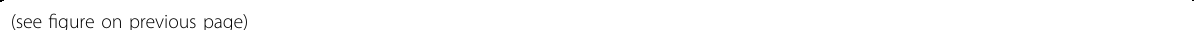
Fig. 1 mGluR2 is required for SARS-CoV-2 infection and directly interacts with the S protein. a Knockdown of mGluR2 was measured by use of qPCR in Vero-E6 cells, Caco-2 cells, and HPAE cells. simGluR2#1 and simGluR2#2, siRNAs speci fi c for mGluR2 mRNA from monkey and human, respectively. siControl, scrambled RNA. b , c mGluR2-silenced Vero-E6 cells ( b ), Caco-2 cells ( b ) or HPAE cells ( c ) were infected with HRB25. At 24 h p.i., virus in the culture supernatant or in the cell lysate (HPAE cells) was detected by use of plaque assays or qPCR. d , e mGluR2-transfected cells were infected with HRB25. At 24 h p.i., virus in the culture supernatant was detected by use of plaque assays ( d ). The expression of exogenous mGluR2 in HEK293 cells and HEK293-ACE2 cells was con fi rmed by western blotting assay ( e ). f – i mGluR2-Flag and SARS-CoV-2 S-Myc ( f ), SARS-CoV-2 S1-Myc ( g ), SARS-CoV-2 RBD-Myc ( h ), or SARS-CoV-2 S1- Δ RBD-Myc ( i ) were co-transfected into HEK293 cells and then immunoprecipitated by using anti-Flag agarose beads. j – l Puri fi ed recombinant GST-tagged mGluR2 ectodomain (mGluR2-GST) was pooled with lysate from SARS-CoV-2 S-Myc- ( j ), SARS- CoV-2 S1-Myc- ( k ) or SARS-CoV-2 RBD-Myc- ( l ) transfected HEK293 cells and then pulled down by using anti-GST beads. m , n mGluR2-GST was pooled with cell lysate from SARS-CoV-2-infected Vero-E6 cells ( m ), or puri fi ed SARS-CoV-2 S1 subdomain protein (SARS-CoV-2 S1-His) ( n ) and then pulled down by using anti-GST beads. o , p Vero-E6 cells ( o ), Caco-2 cells ( o ), and HPAE cells ( p ) were treated with mGluR2-Ab at different concentrations or IgG2a (20 μ g/mL for Vero-E6 cells and Caco-2 cells; 15 μ g/mL for HPAE cells) for 1 h at 4 °C, and then infected with HRB25. Virus in the culture supernatant or in the cell lysate (HPAE cells) was detected by use of plaque assays or qPCR at 48 h p.i.. q HRB25 was pooled with different concentrations of mGluR2-GST or GST (200 μ g/mL), and then Vero-E6 cells were infected by mixing for 1 h at 37 °C. Virus in the culture supernatant was detected by use of plaque assays at 24 h p.i.. The data shown are representative results from three independent experiments ( a – d , o – q n = 3), means ± SD, Student ’ s t -test, ns, not signi fi cant, **P < 0.01, ***P <